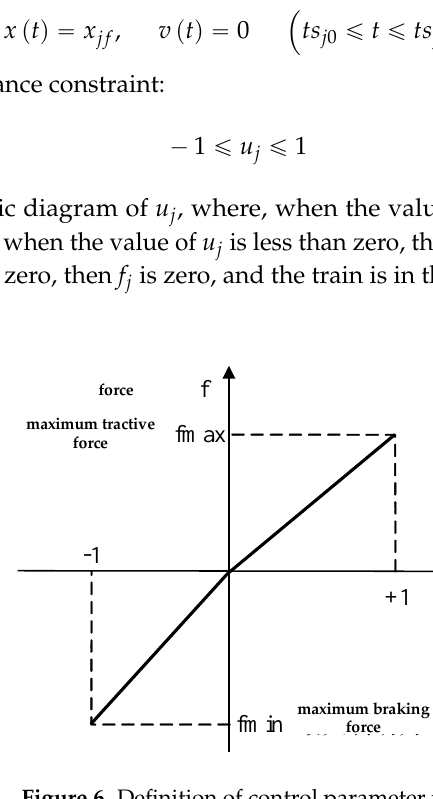
Figure 6. Definition of control parameter u.